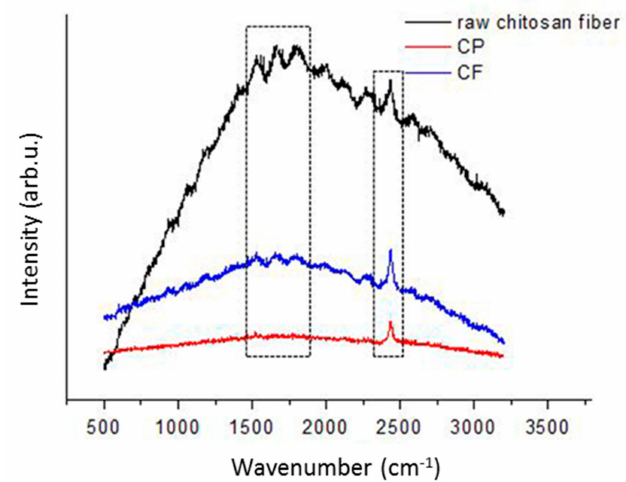
Figure 1. Raman scattering spectrum of chitosan in raw chitosan fiber, chitosan fiber (CF) dressing, and chitosan sponge (CP) dressing. The left rectangle included C–N–H and C = O bond group, the right rectangle indicated O–H carboxylic